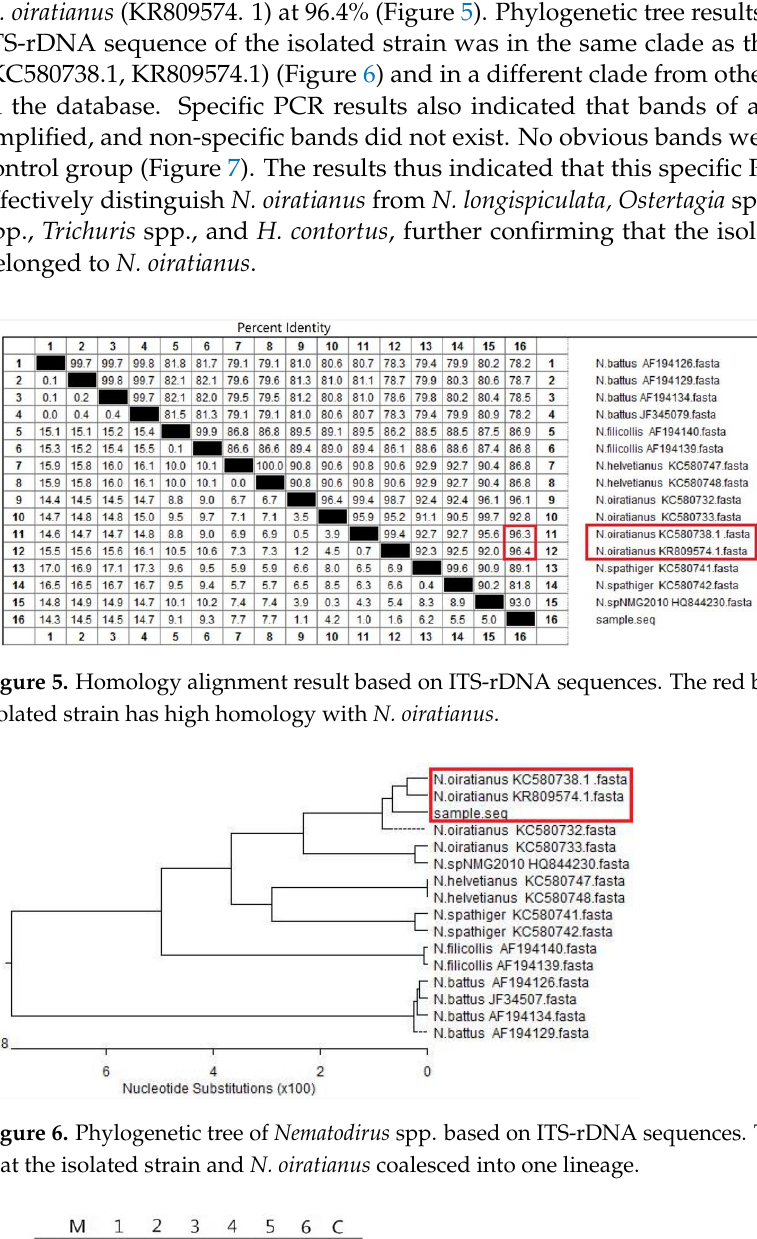
Figure 4. Morphology of L3 of Nematodirus. spp. ( a ) L3 larva (100×). ( b ) Tail of L3 larva (100×). ( c )